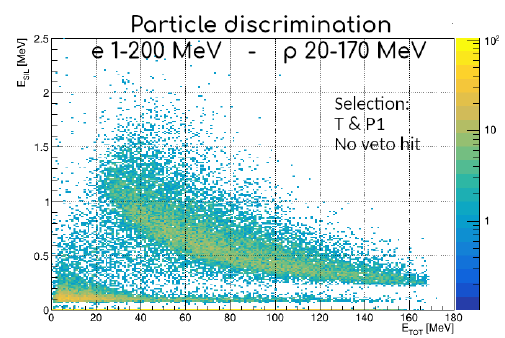
Figure 3. ∆ E vs E method for particle identification with a sample of simulated electrons and protons; in the plot, E SIL is the energy deposit in the 1 st tracker plane, E TOT is the energy deposit in the detector.